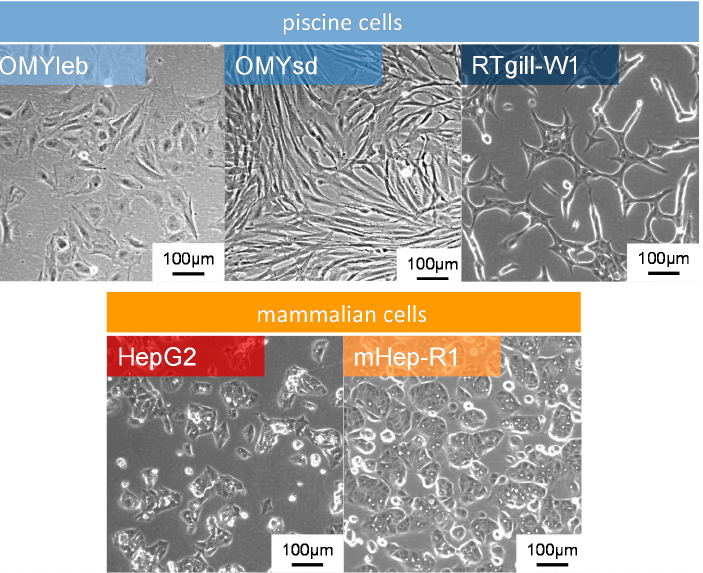
Figure 3. Light-microscope images of the piscine and mammalian cell lines used in this assay. The scale bar represents 100 µm in all images.